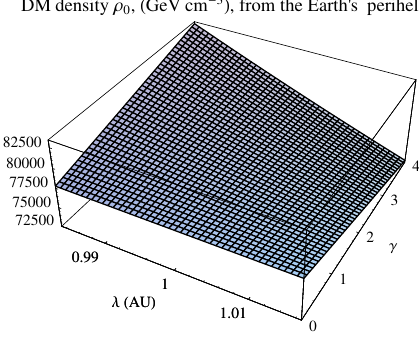
Figure 2. Upper bounds, in GeV cm − 3 (1 GeV cm − 3 is equivalent to 1 . 78 10 − 24 g cm − 3 ), × on the DM density parameter ρ 0 as a function of the parameters λ and γ of Equation (11). The supplementary perihelion precessions of Table 1 for Earth, Mars and Saturn were adopted along with the analytical prediction of Equation (13). The characteristic length λ , in AU, is assumed to vary from r min = a (1 e ) to r max = a (1 + e ) −